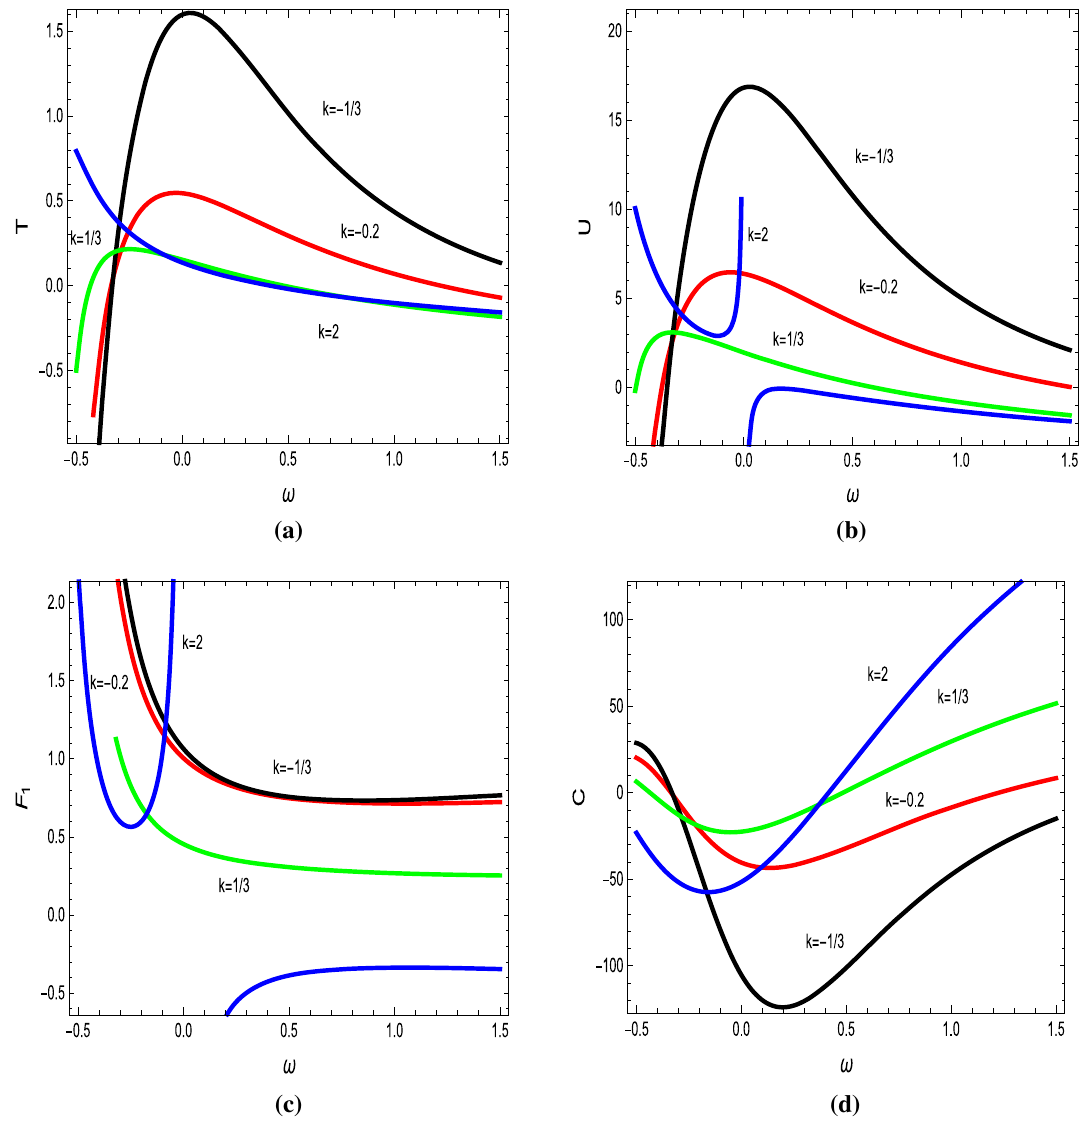
Fig. 8 a – d Show the variation of the thermalization temperature T , Helmholtz free energy F 1 , total energy U and specific heat in constant volume C against the Brans–Dicke parameter ω respectively for differ- ent values of the equation of state parameter k in Brans–Dicke gravity’s